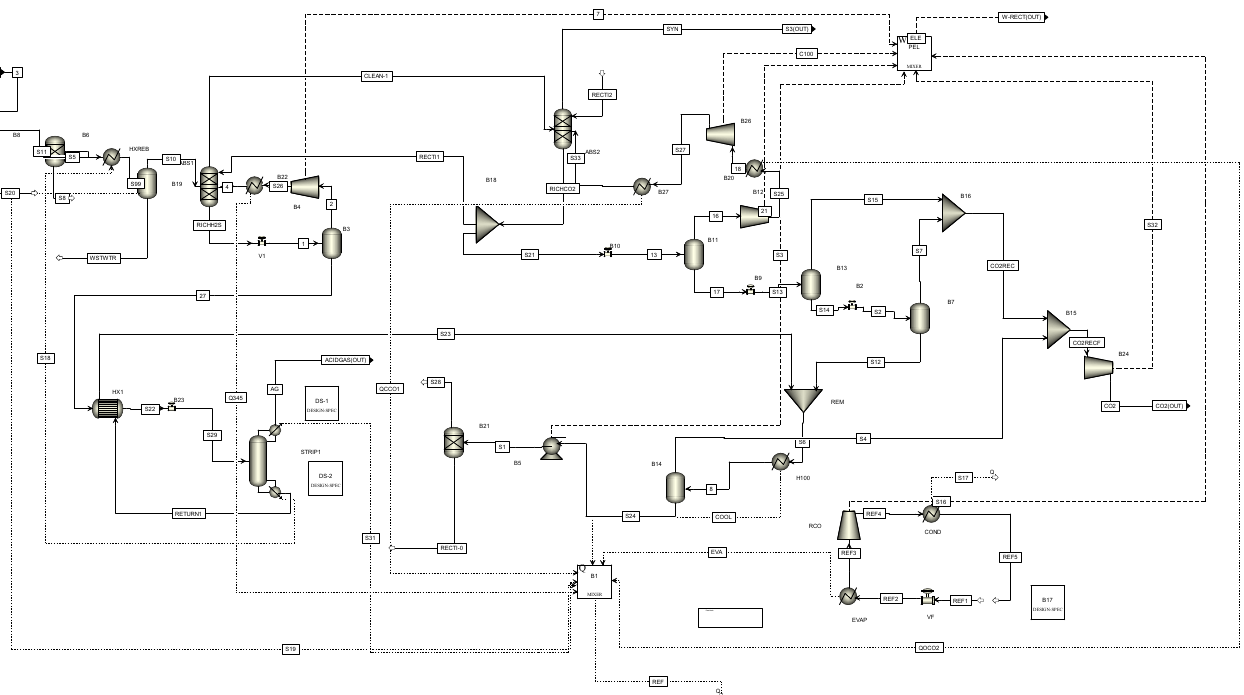
Figure A4. Aspen flowsheet of the Rectisol